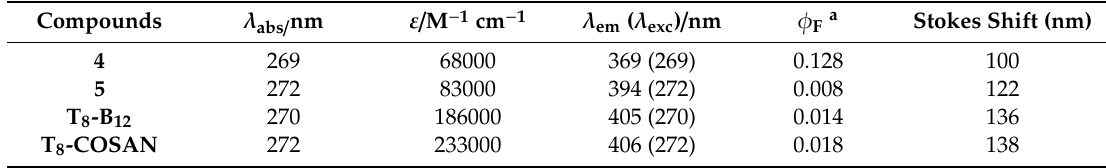
Figure 2. Absorption and emission spectra of ( a ) 4–5 and ( b ) T 8 -B 12 and T 8 -COSAN recorded in CH 3 CN (au: Arbitrary units). Table 1. Solution-state photophysical